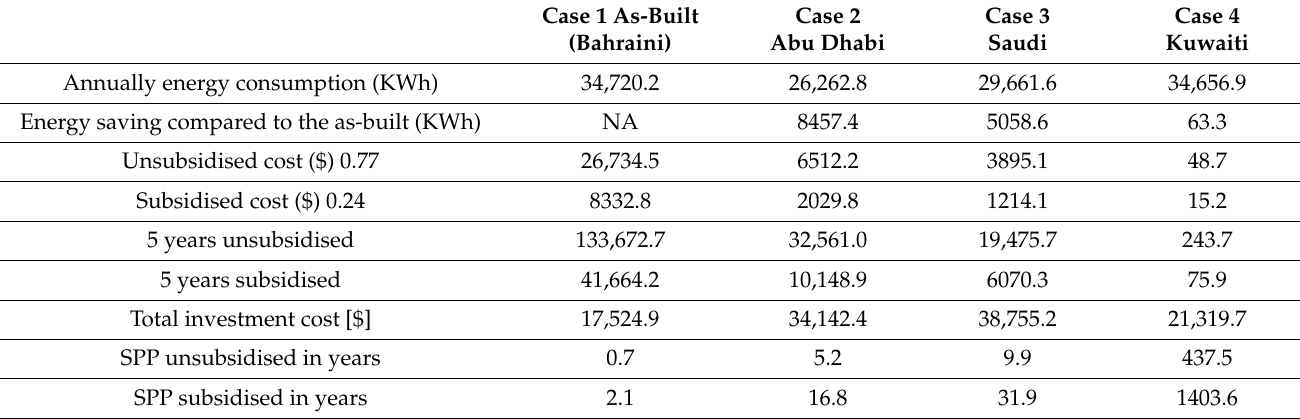
Table 8. Simple payback period, including the subsidised and unsubsidised energy costs.